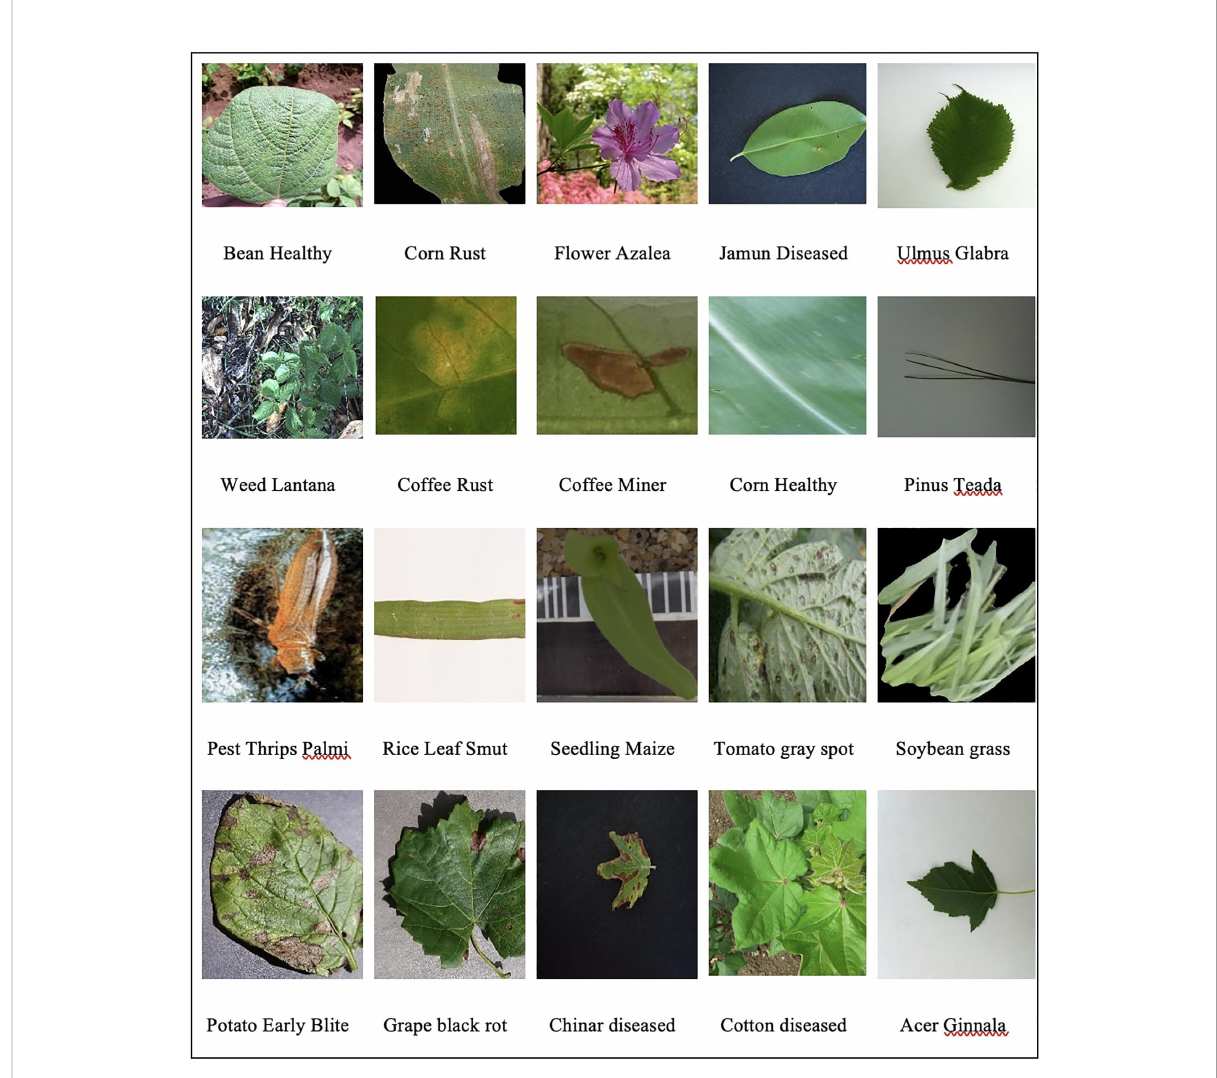
FIGURE 1 Sample images from agrinet